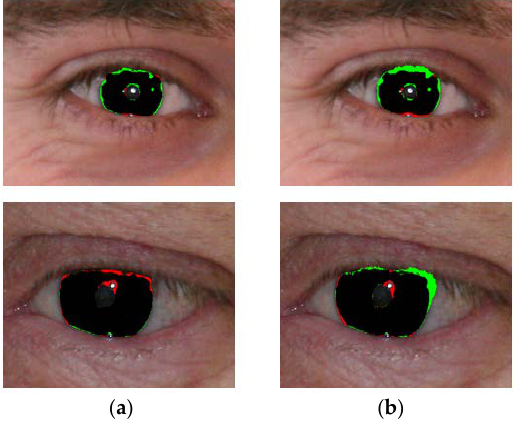
Figure 21. Comparison of iris thin boundary. Segmentation results obtained by ( a ) IrisDenseNet and ( b ) SegNet.